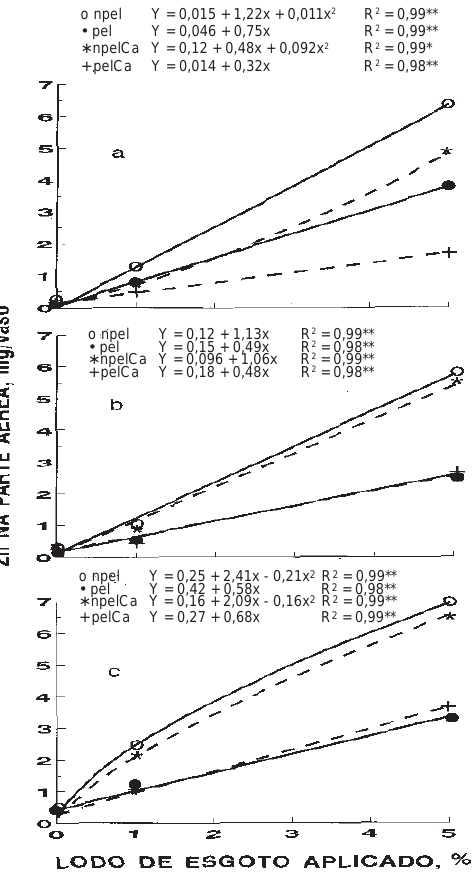
Figura 2. Quantidades absorvidas de Zn pela parte aérea do milho em função da adição de lodo de esgoto peletizado ou não, com ou sem CaCO 3 , em três solos: a) LE, b) LR e c) LV.npel = não peletizado; pel = peletizado; npelCa = não peletizado e com CaCO 3 ; pelCa = peletizado e com CaCO 3